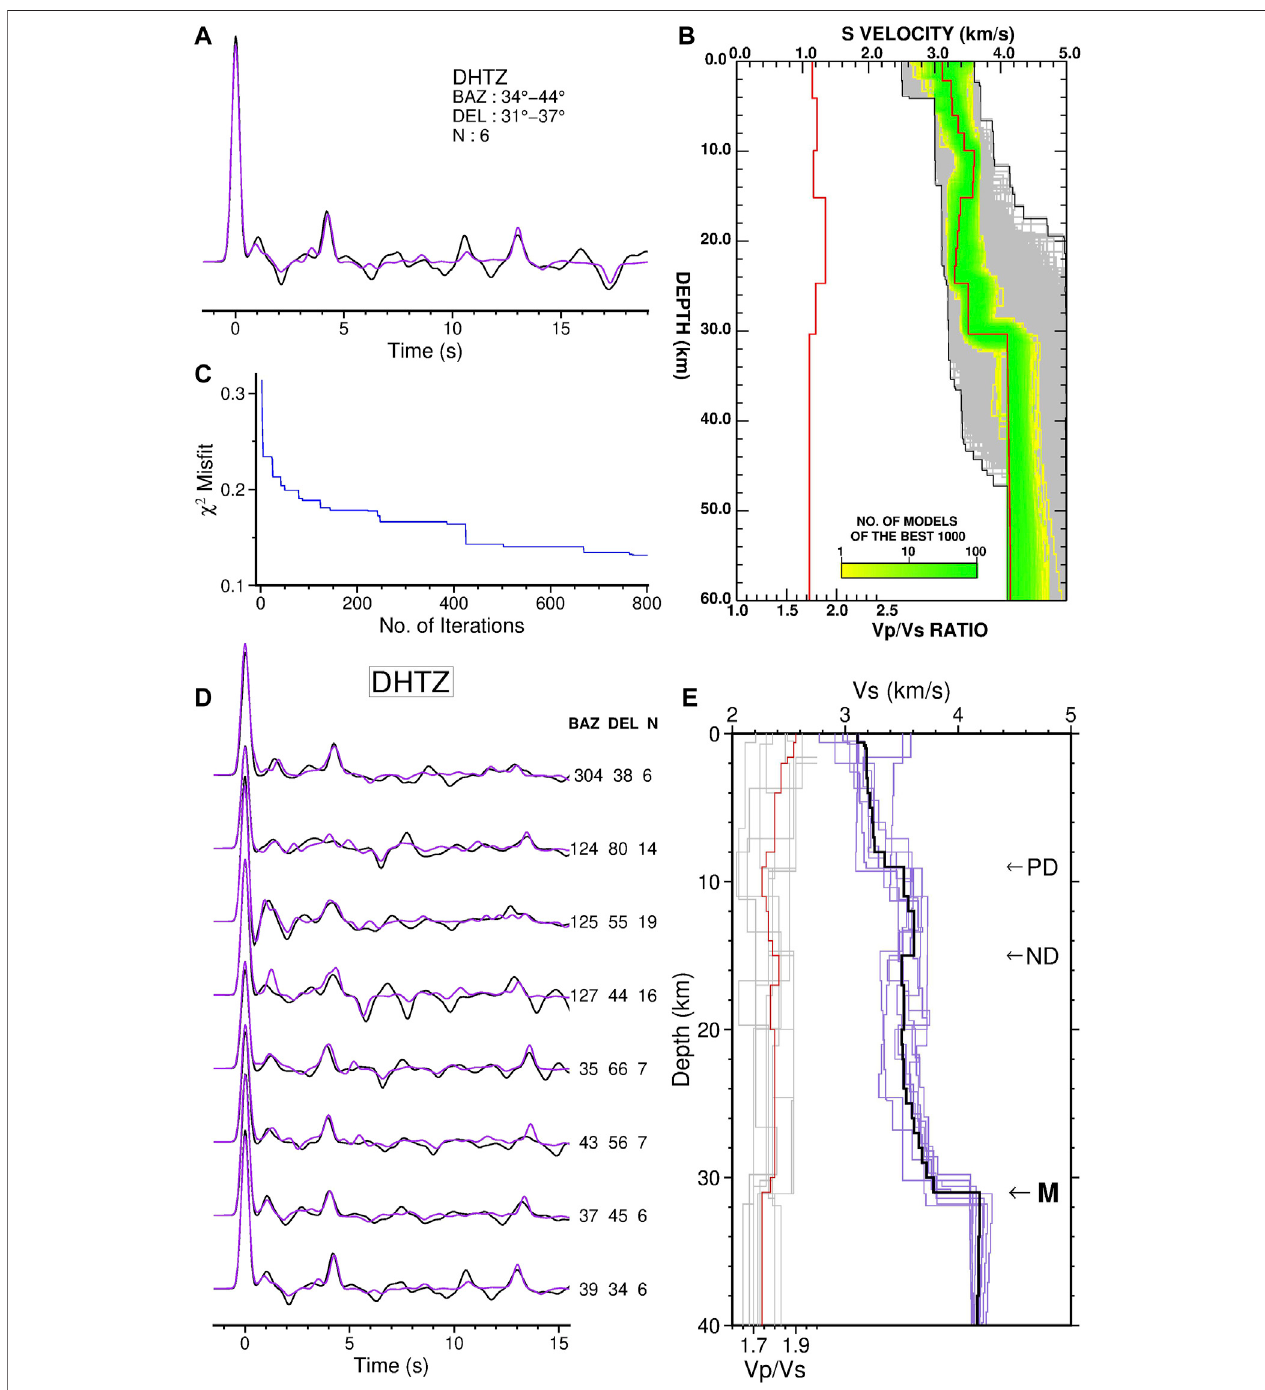
FIGURE 3 | Results of the Neighborhood Algorithm (NA) inversion of P RFs for station DHTZ. (A) Example of an observed P RF (black line) and its corresponding synthetics (purple line) predicted by the optimal Vs and Vp/Vsmodels obtained with the nonlinear NA inversion. The observed PRF asthe input data is calculated by the stackofanumber(N)ofselectedhigh-qualityRFsinanarrowrangeofbackazimuth(BAZ)andepicentraldistance(DEL).Forthisexamplecase, N (cid:2) 6. (B) Thebest- fi tVs (blackline)andVp/Vs(redline)modelsoutofthebest1000models(yellowandgreenregions)searchedamongatotalof64,100models(greyregion). (C) Themis fi t function at subsequent iterations. (D) Eight observed stacked P RFs (black lines) and their corresponding model-predicted synthetics (purple lines) adopted in the NA inversion for station DHTZ. The respective average back azimuth, epicentral distance, and number of RFs involved for each stack are displayed on the right. (E) Final Vs (thick black line) and Vp/Vs (red line) models calculated by averaging all the best- fi t models (purple and grey lines) from the NA inversion of individual P RF stacks. The Moho and intracrustal positive and negative discontinuities are identi fi ed and marked by M, PD, and ND, respectively.